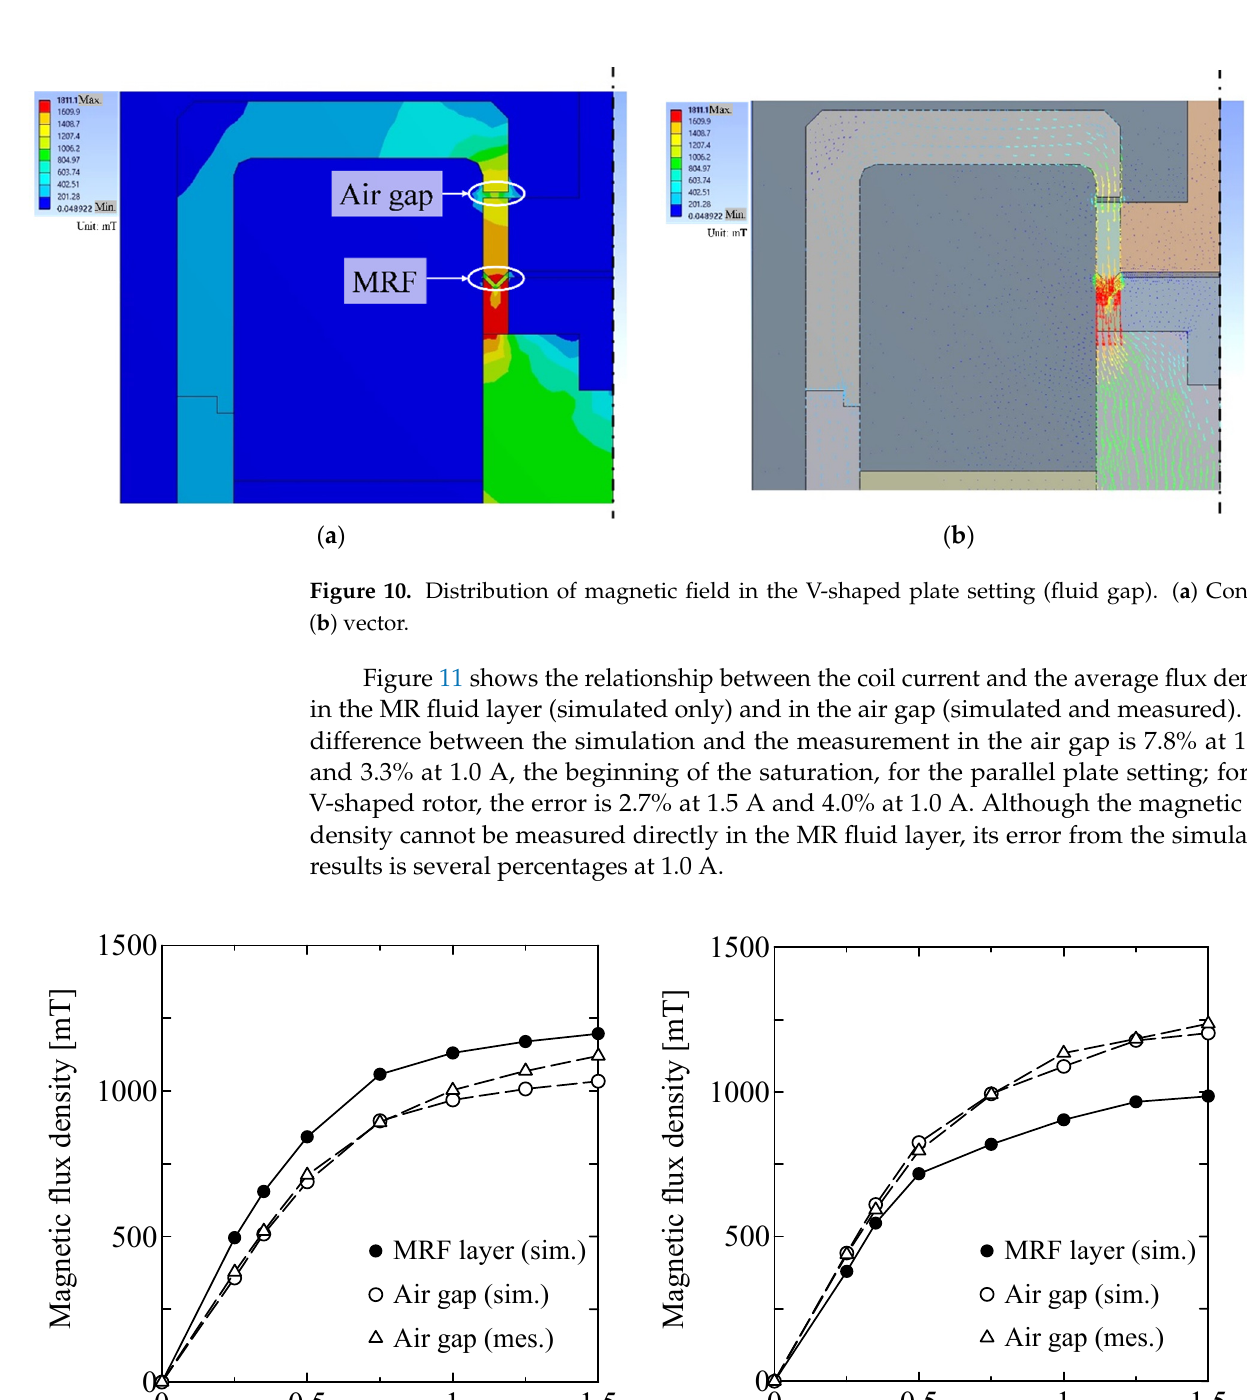
Figure 11. Analytic results on current vs. magnetic field. ( a ) Parallel plate, ( b ) V-shaped plate.